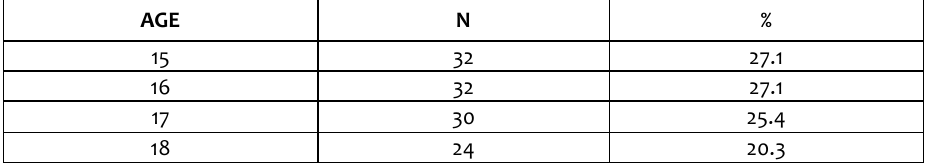
Table 2. Distribution of Obese Participants by